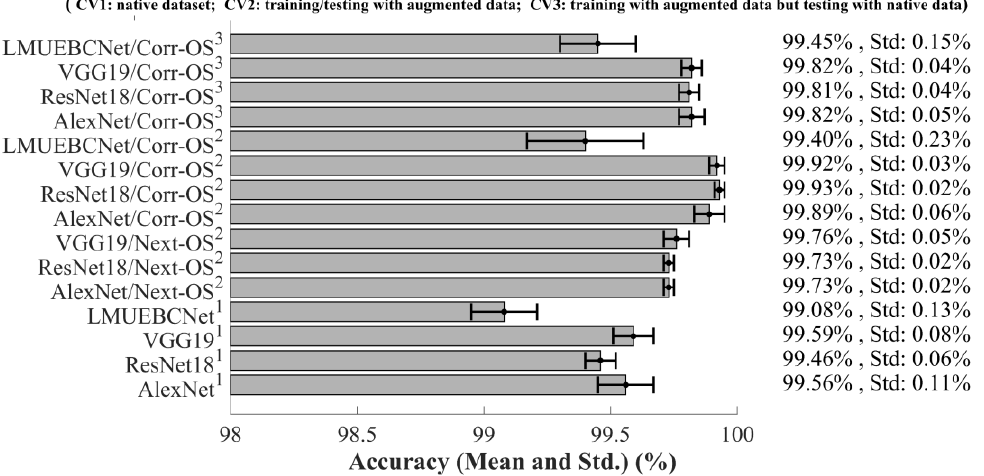
Figure 6. Standard deviation and total accuracy of LMUEBCNet/AlexNet/ResNet18/VGG19 using native/Next-OS/Corr-OS ( K = 1) dataset in CV1/CV2/CV3.